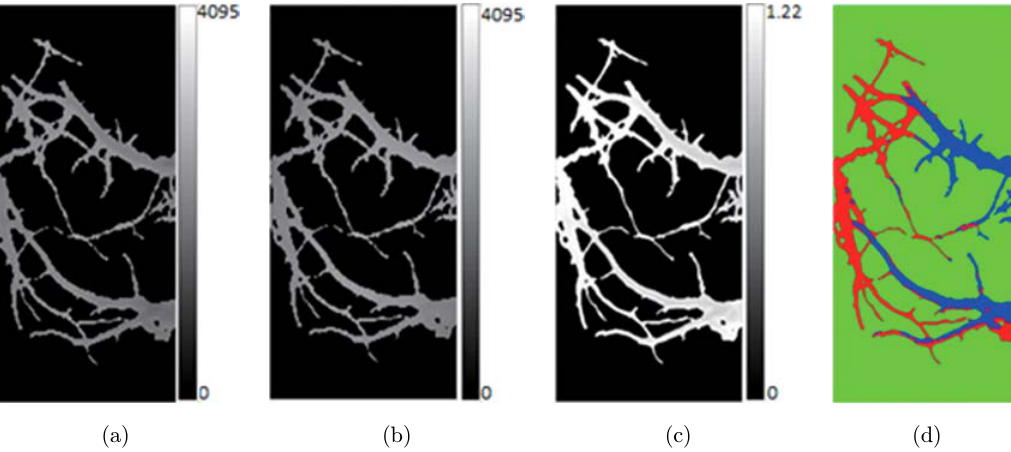
Fig. 5. The separation of arteries and veins (a) OIS vessel network at 630 nm (b) OIS vessel network at 870 nm (c) The ratio R of OIS images (d) The artery – vein separation (the blue vessels represent veins and the red vessels represent arteries).